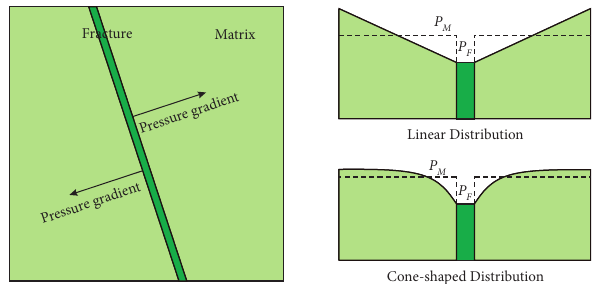
Figure 2: Illustration of linear and cone-shaped pressure distributions in fractured